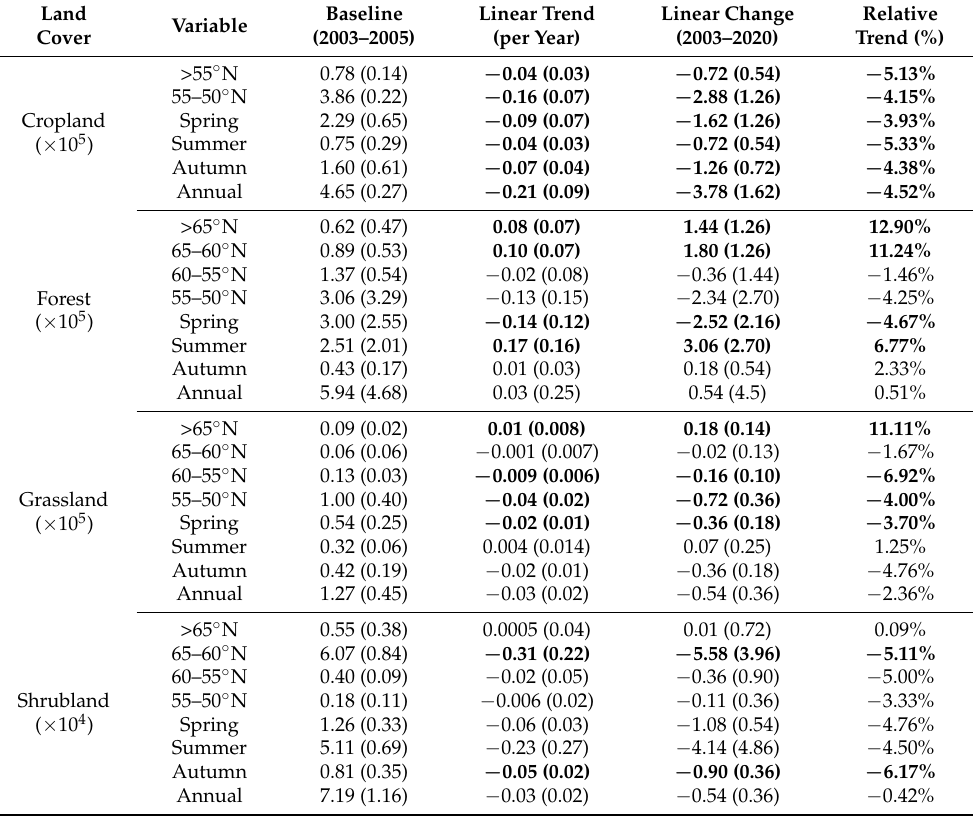
Figure 7. Time series and linear trends of NEA fire counts ignited on different land covers from 2003 to 2020. Panel ( a ) is the total annual fire counts; ( b – d ) are the fire counts occurred in spring, summer, and autumn, respectively. Table 2. Statistical linear trends of fire counts in different land cover types, latitudinal zones, and seasons during 2003 to